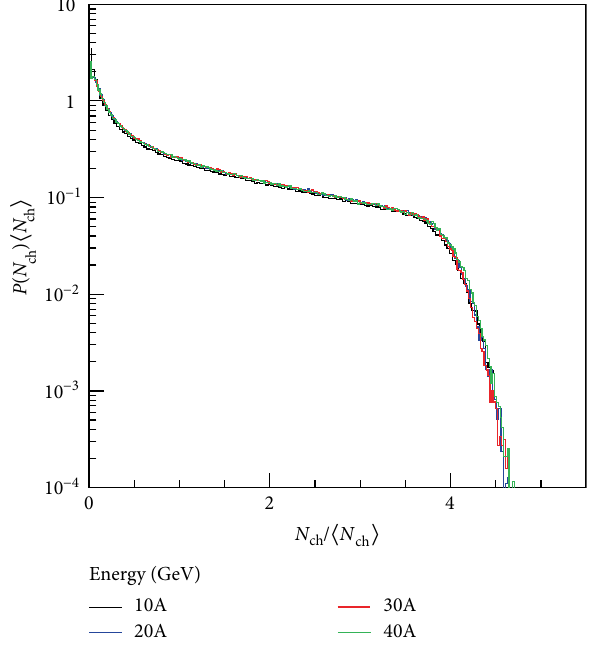
Figure 7: Scaled Multiplicity distributions of relativistic charged particles for the minimum bias events at the four beam energies considered.